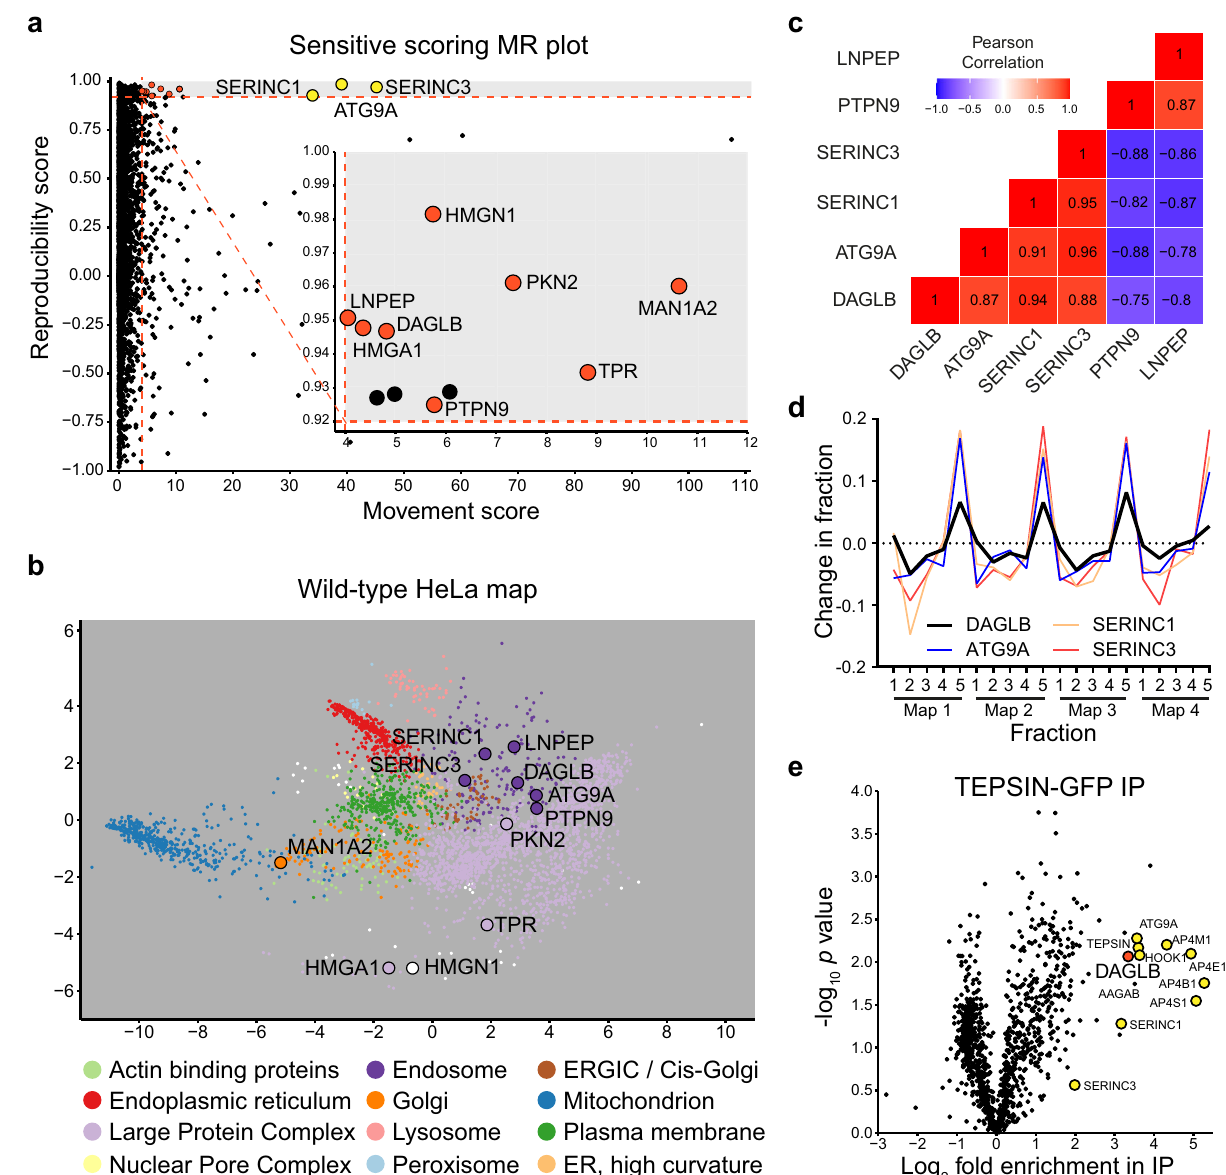
Fig. 1 Sensitive analysis of Dynamic Organellar Maps identi fi es DAGLB as an AP-4 cargo protein. a Dynamic Organellar Maps of AP4B1 knockout (KO) and AP4E1 KO HeLa cells were compared to maps of wild-type HeLa cells (each in duplicate, totalling four comparisons). Sensitive statistical scoring was used to detect proteins with a signi fi cantly altered distribution in the AP-4 KO cells that were not detected in a previous stringent analysis 2 (see Methods for details). For 3926 proteins pro fi led across all maps, the ‘ MR ’ plot displays the median magnitude of shift (M) and the mean within-clone reproducibility of shift direction (R). The known AP-4 cargo proteins, ATG9A, SERINC1 and SERINC3 (marked in yellow), were identi fi ed with high M and R scores, as expected. The inset plot displays 8 additional hits (marked in red) whose subcellular localisation was signi fi cantly and reproducibly shifted in the AP-4 KO lines, with a false discovery rate of ~25%. Proteins that passed the M and R cut-offs but had poor across-clone reproducibility were not considered as hits (marked in black). b The hits from ( a ) are highlighted on a principal component analysis (PCA)-based visualisation of a deep Dynamic Organellar Map of wild-type HeLa cells 19 (combined data from six replicate maps [http://mapofthecell.biochem.mpg.de/]. Each scatter point represents a protein and proximity indicates similar fractionation pro fi les. Colours indicate subcellular compartment assignment by support vector machine-based classi fi cation (white indicates compartment unassigned). Three hits, DAGLB, PTPN9 and LNPEP, map to the endosomal cluster (dark purple), like known AP-4 cargo proteins. c Heat map showing pairwise Pearson correlations between the shift pro fi les (abundance distribution pro fi les from knockout maps subtracted from the pro fi les from control maps) of DAGLB, ATG9A, SERINC1, SERINC3, PTPN9 and LNPEP. d The shift pro fi les of DAGLB, ATG9A, SERINC1 and SERINC3 are highly correlated, making DAGLB a strong new candidate AP-4 vesicle protein. Maps 1 and 2 are AP4B1 KO maps subtracted from wild-type maps; Maps 3 and 4 are AP4E1 KO maps subtracted from wild-type maps. Fraction numbers 1-5 refer to increasing centrifugation speeds. e High-sensitivity low-detergent immunoprecipitations (IP) from HeLa cells stably expressing the AP-4 associated protein TEPSIN-GFP were analysed by SILAC-based quantitative mass spectrometry 2 . Data were analysed in comparison to mock immunoprecipitations from wild-type HeLa cells with a two-tailed one sample ratio t test against 0 (each in triplicate, n = 3). DAGLB (marked in red) was highly enriched along with known AP-4 vesicle proteins (marked in yellow). Source data are provided as a Source Data fi